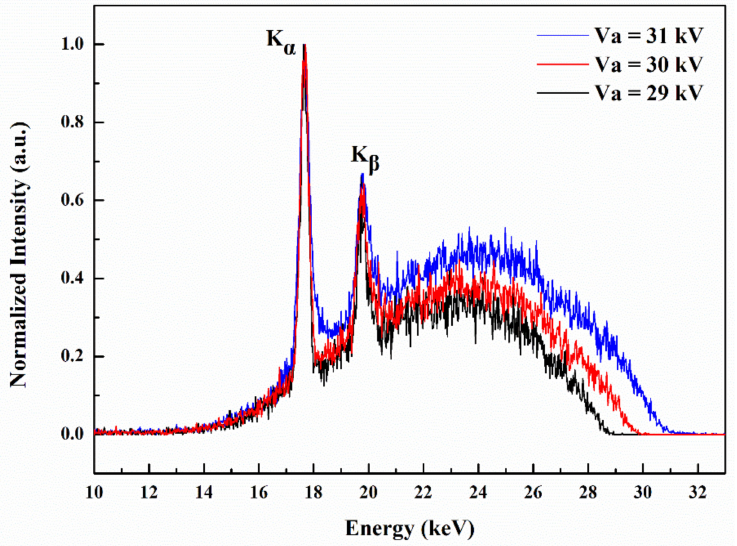
Figure 6. The normalized X-ray energy spectrum of the flat-panel X-ray source recorded under different anode voltages.